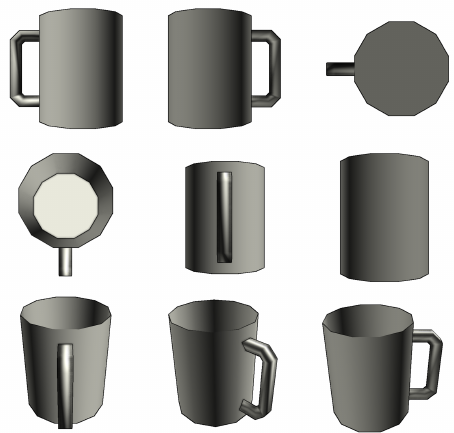
Figure 6. An example of a model from ShapeNetCore dataset.